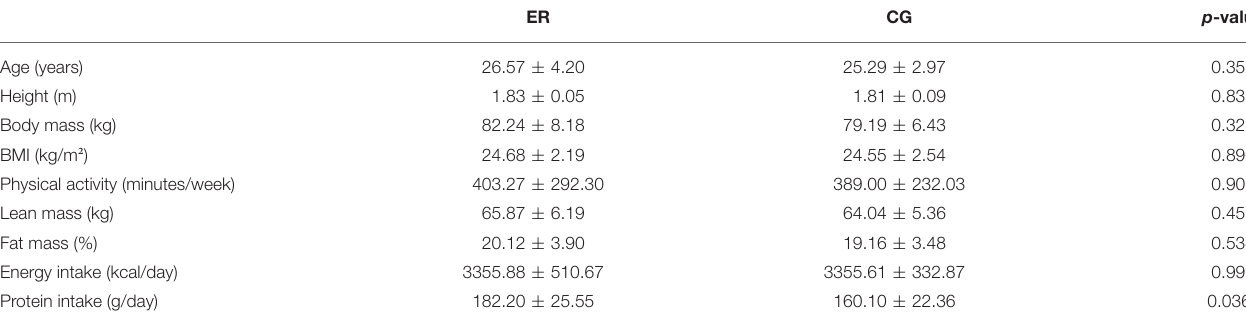
TABLE 1 | Baseline characteristics in the energy-restricted group (ER) and the control group (CG) during the maintenance week (week